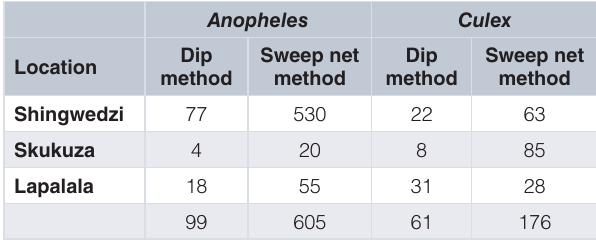
Table 1. Total number of larvae collected per genus per collection method at each